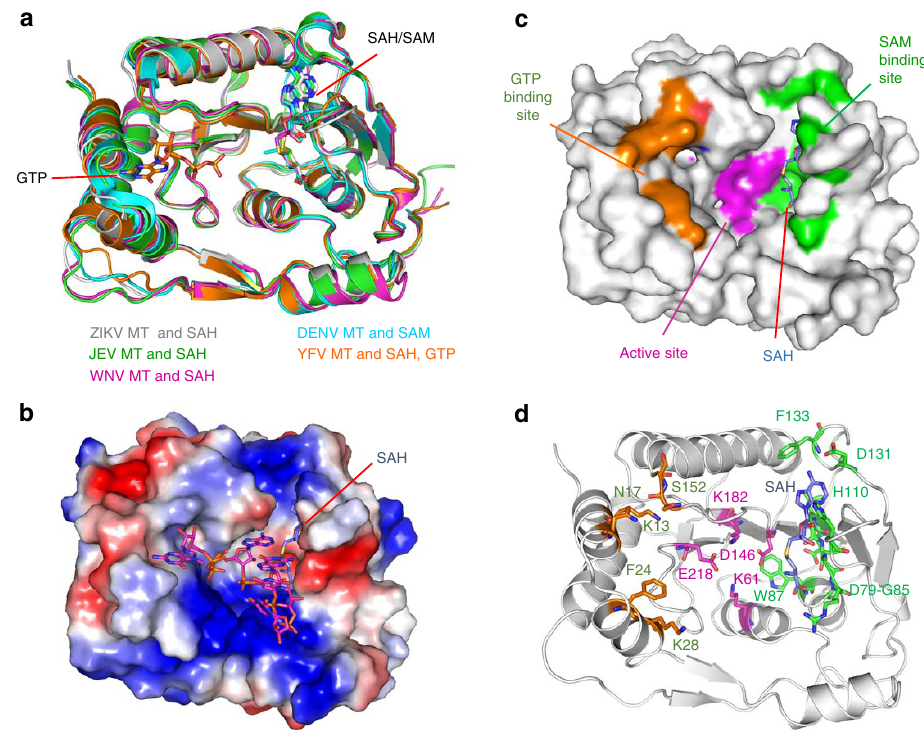
Figure 3 | Structure of ZIKV NS5 methyltransferase domain (MT). ( a ) Comparison of the structures of the MT domains of ZIKV, DENV (PDB, 3P97), YFV (PDB, 3EVC), WNV (PDB, 2OY0) and JEV (PDB, 4K6M). SAH or SAM and GTP bound to the MT domains are shown by the stick models. ( b ) Surface of ZIKV NS5 MT involved in Cap-0 RNA binding coloured by electrostatic potential. Positively charged surface are coloured blue and negatively charged surface red. The Cap-0 RNA (5 0 - m7 G 0ppp A 1 G 2 U 3 U 4 G 5 U 6 U 7 -3 0 ) is modelled into the ZIKV NS5 MT by superposition of the DENV MT/Cap-0 RNA complex structure (PDB, 5DTO) onto ZIKV MT. ( c ) Surface representation of ZIKV NS5 MTshowing the active site and the binding sites for GTP and SAM. ( d ) Key residues of ZIKV NS5 MTessential for GTP binding (orange), SAM binding (green) and catalysis (magenta). SAH is shown by the blue stick